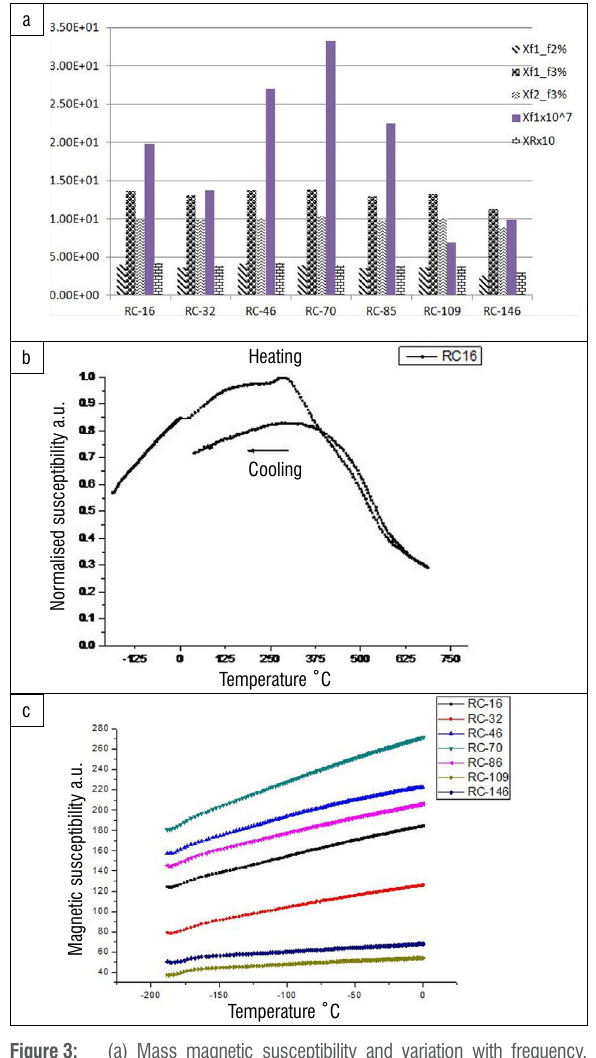
Figure 3: (a) Mass magnetic susceptibility and variation with frequency. f1 =1000 Hz; f2=4000 Hz; f3= 16 000 Hz. (b) Thermomagnetic susceptibility curve from approximately -190 °C to 700 °C for sample RC-16; the behaviour of the other samples seems similar. (c) Low temperature of magnetic susceptibility. The slope is related with SP mean